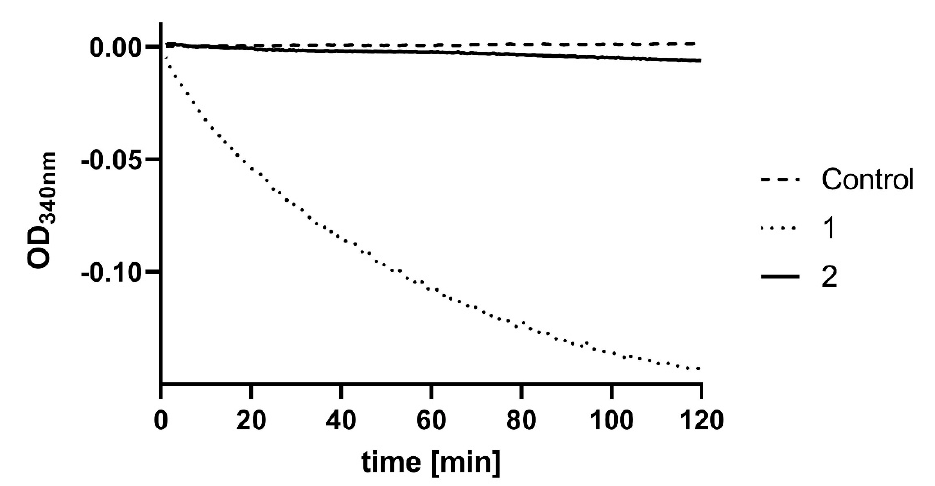
Figure 1. Time-resolved measurement of the absorption at 340 nm (enone group) of 200 µM 1 , 2 or solvent (DMSO) mixed with 6.5 mM glutathione in phosphate-buffered saline (PBS). Data are means ± SD of at least four independent measurements every 30 s.